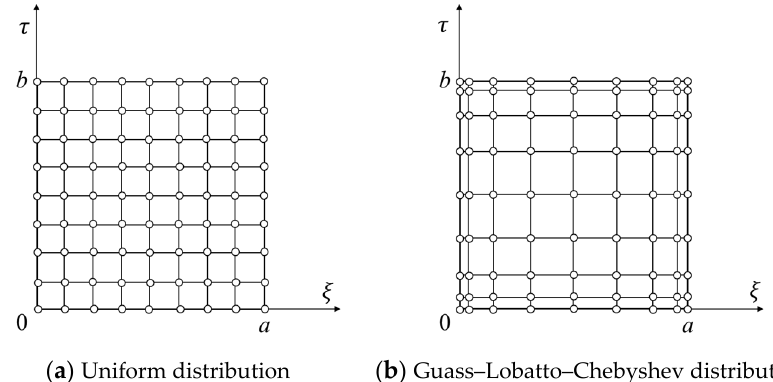
Figure 1. Orthogonal rectangular grids.